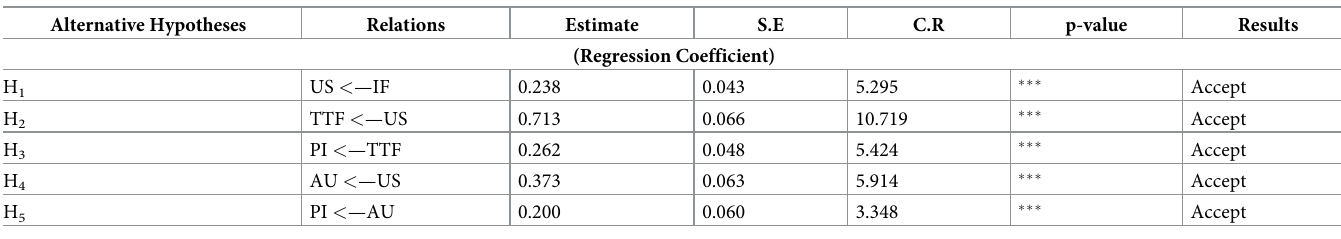
Table 6. Evaluation of structural model.